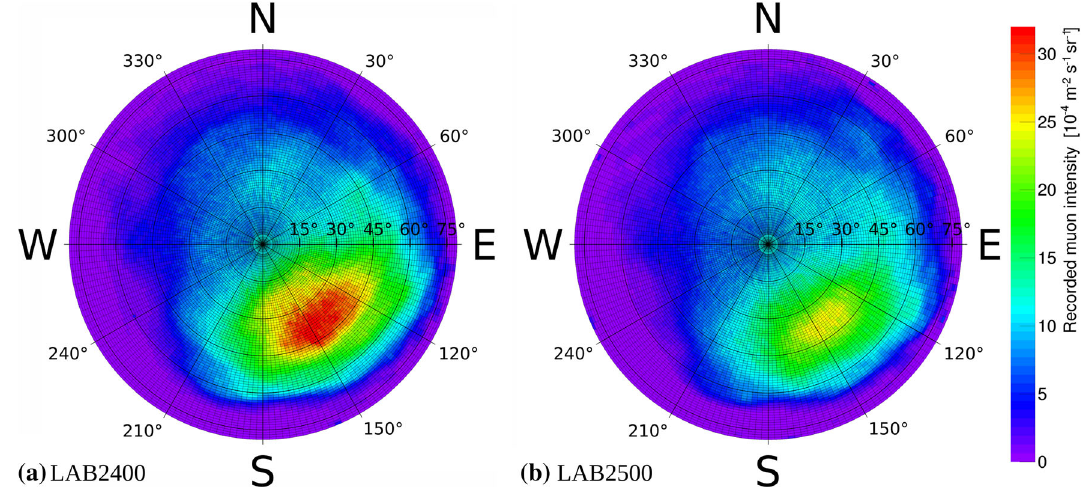
Fig. 7 Muon intensity measured in LAB2400 (left) and in LAB2500 (right) plotted as a function of the azimuth and zenith angle. The maxima measured around θ = 40 ◦ and φ = 150 ◦ point towards the Rioseta valley